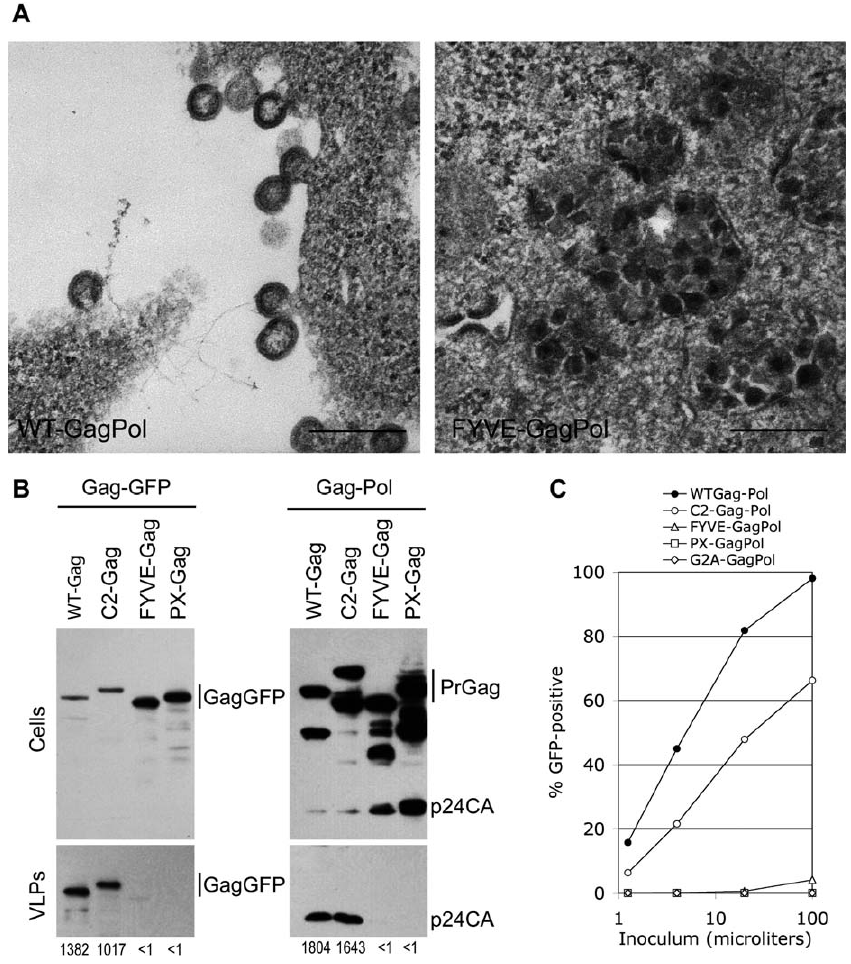
Figure 5. HIV-1 Particles Are Not Released When Assembly Is Targeted to Endosomes (A) Electron microscopy analysis of 293T cells expressing CherryFP-Rab5aQ79L together with WT-Gag-Pol (left), in which a portion of the PM is shown, or FYVE-Gag-Pol (right), in which mature virions and assembly intermediates are found in intracellular vesicles. Scale bars indicate 200 nm. (B) Western blot analysis of 293T cells expressing WT (wild type) or retargeted Gag-Pol or Gag-GFP proteins. Samples were collected at 24-h post- transfection. Cell and virion lysates were probed with anti–HIV-1 CA antibodies. Numerical values below the blots indicate VLP Gag-GFP or p24CA signal intensities, derived by densitometry. (C) Infectivity measurements using supernatant collected from 293T cells expressing WT, G2A mutant, or retargeted Gag-Pol proteins along with a packageable HIV-1 GFP expression vector and VSV-G. The percentage of infected (GFP þ ) TE671 target cells is plotted as a function of inoculum